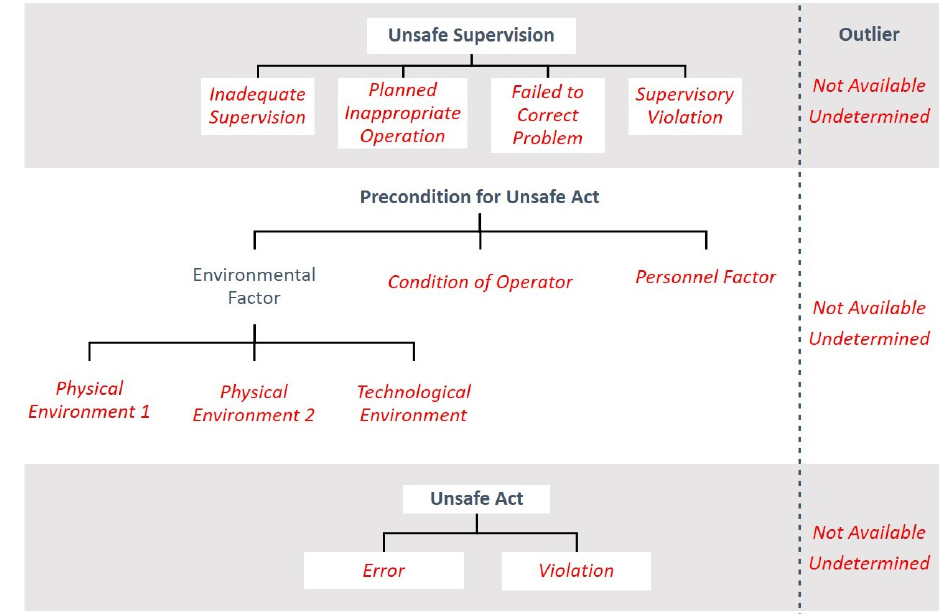
Figure 4. Proposed HFACS-machine learning (HFACS-ML)